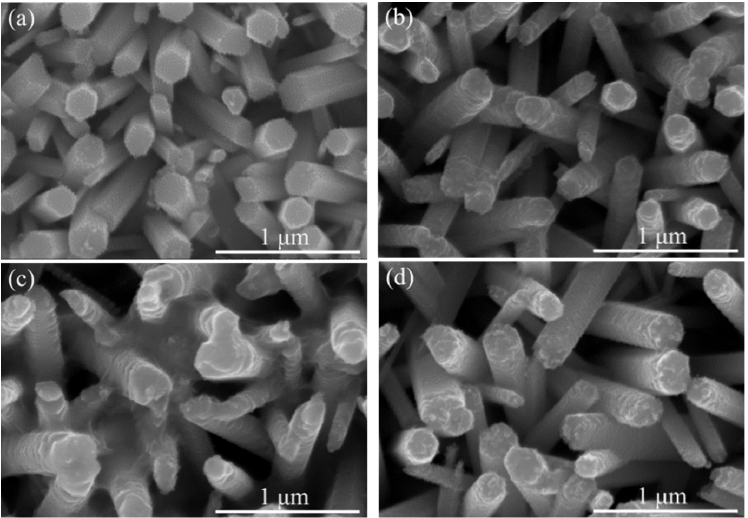
Figure 3. ( a )–( d ) SEM images of Ag 2 S/ZnO nanocomposites with different immersion time of 15, 30, 45, and 60 min, re- spectively.